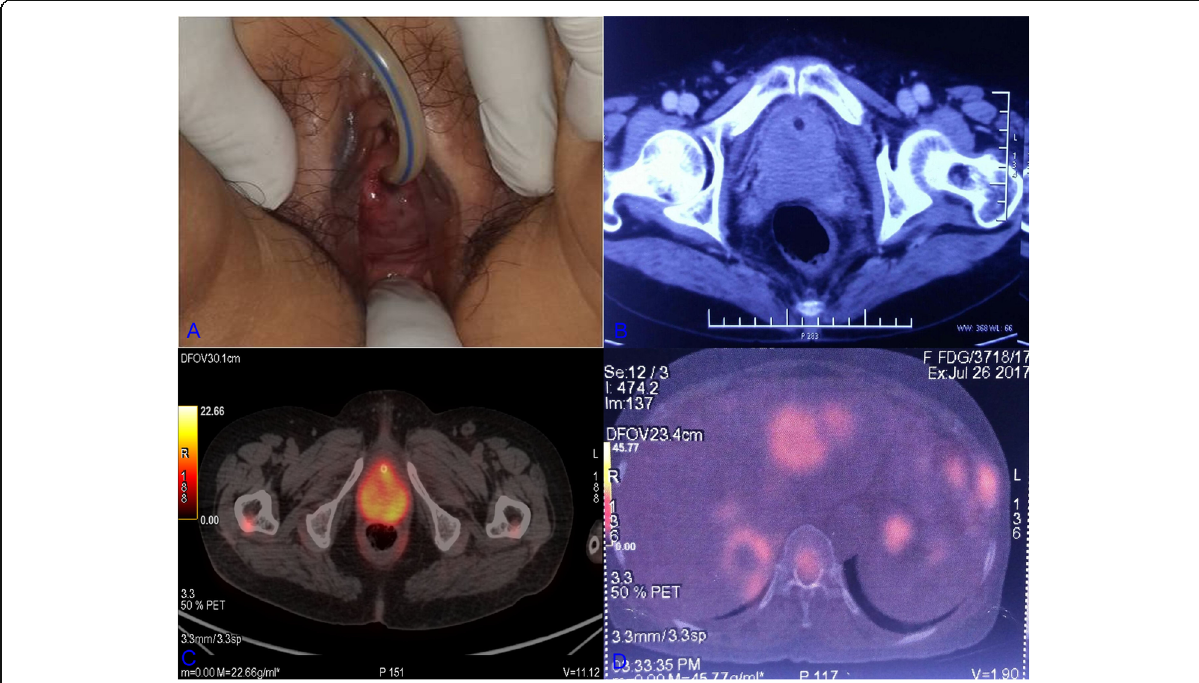
Fig. 1 Clinicoimaging findings: ( a ) Local examination revealed a mass with bluish tinge stretching the external urethral meatus. A catheter was placed which drained clear urine. ( b ) Computed tomography scan showed a large urethral mass which was further highlighted with ( c ) positron emission tomography scan. ( d ) In addition, multiple metastatic lesions were seen in the